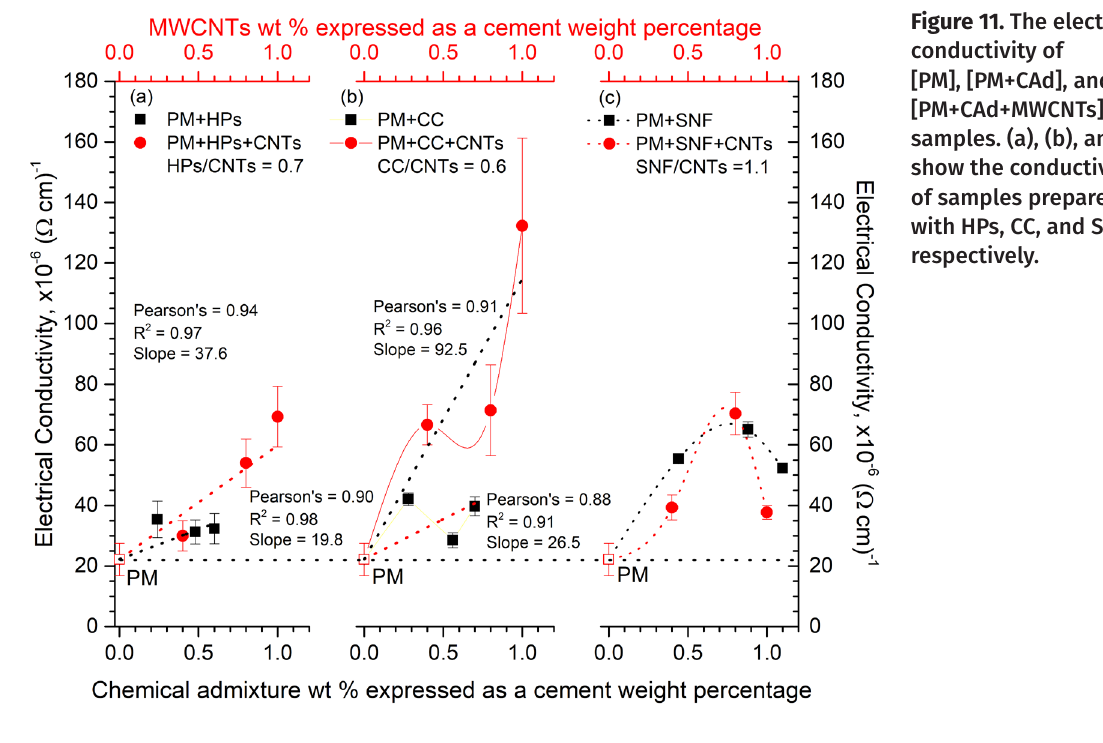
Figure 11. The electrical conductivity of [PM], [PM+CAd], and [PM+CAd+MWCNTs] samples. (a), (b), and (c) show the conductivity of samples prepared with HPs, CC, and SNF,